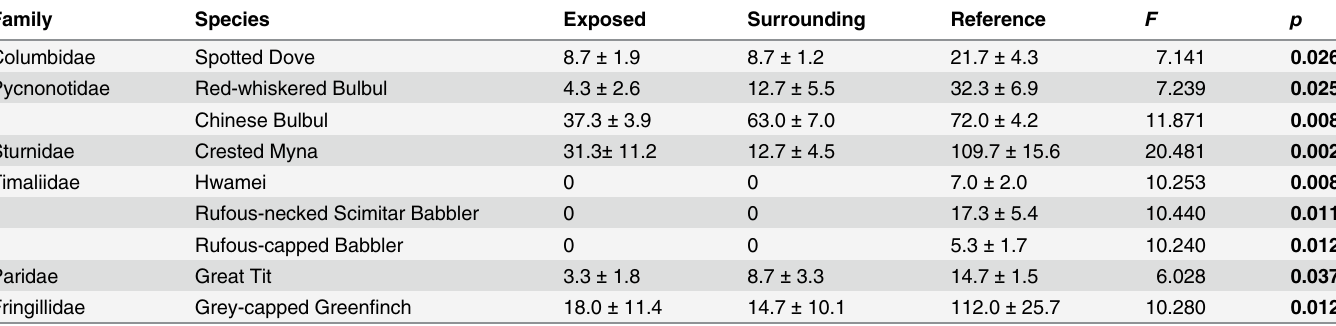
Note : Species include only those with (cid:2) 4 detections and normal distributions. Relative abundance is expressed as mean number of birds detected within 50 m per point at each site. Results of F test, as well as table-wide signi fi cance ( p ) are also given. The F test of signi fi cance uses the type III sums-of- squares obtained from a linear mixed